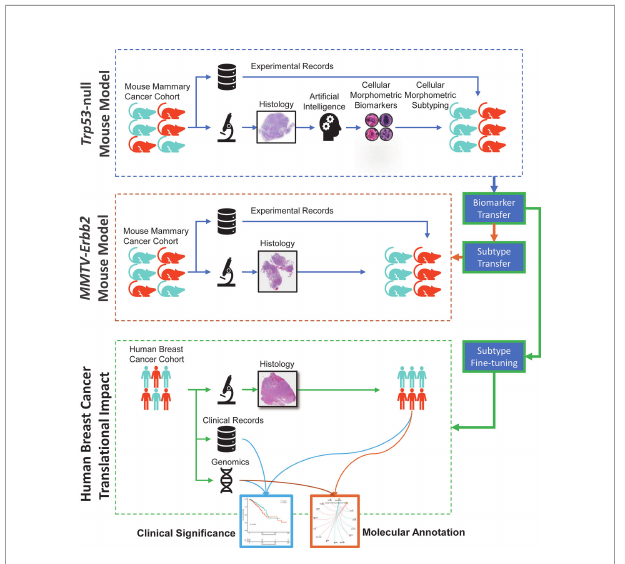
FIGURE 1 | Graphical illustration of our study design with knowledge mining from one mouse mammary model and translation to another mouse mammary tumor model and human breast